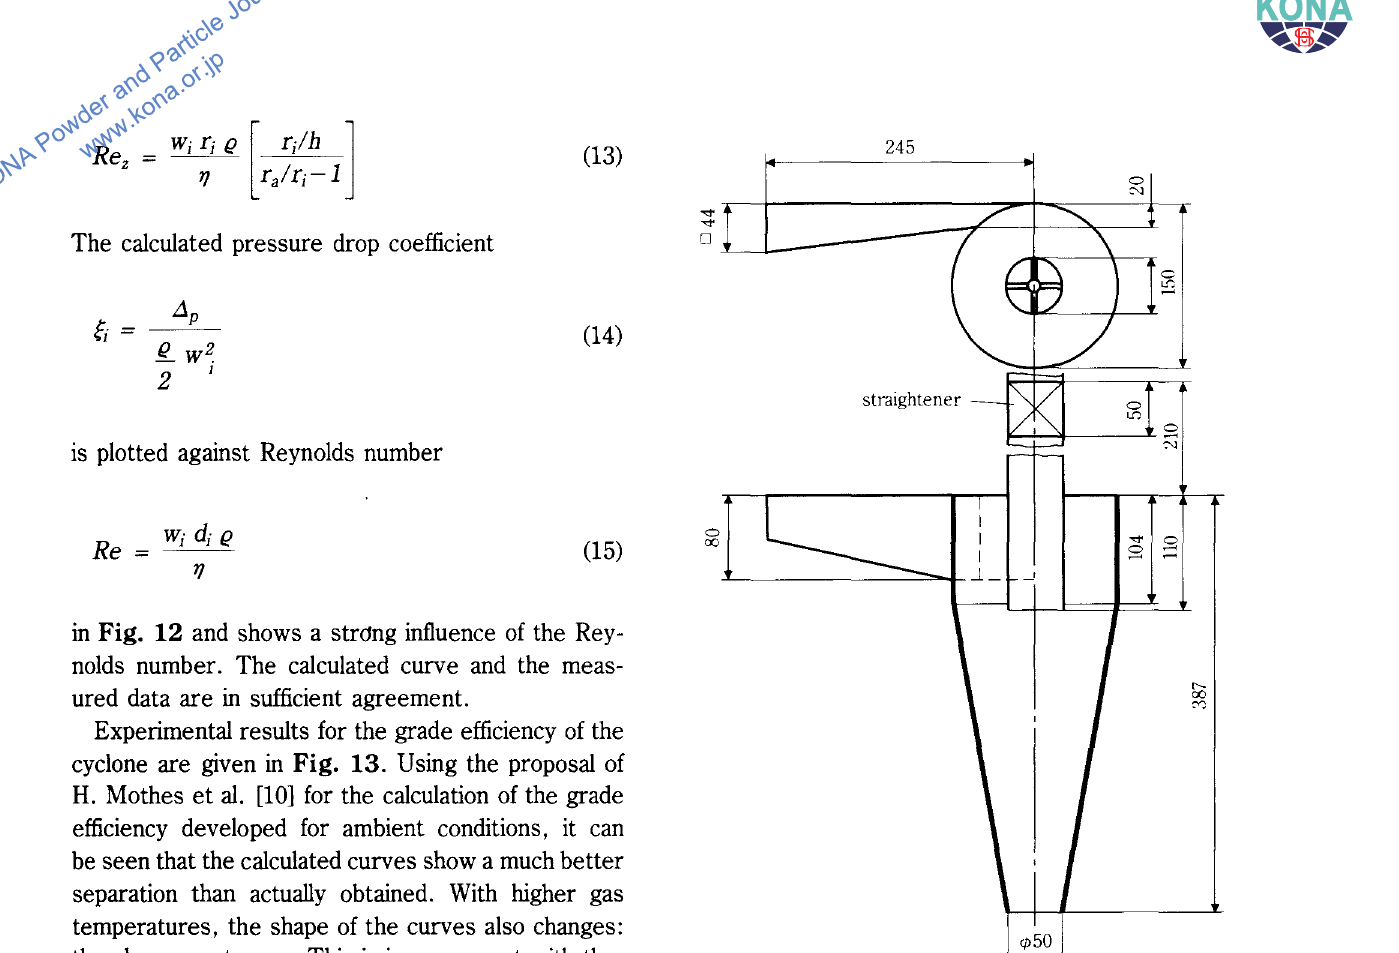
Fig. 11 Dimensions of the cyclone used for hot gas cleaning